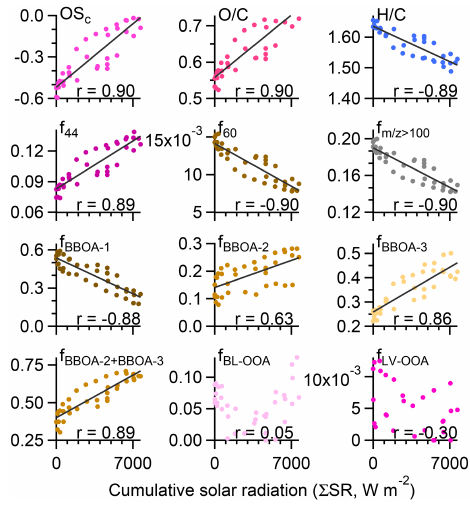
Figure 8. Aerosol chemistry parameters of total BBOA as a func- tion of cumulative solar radiation for the Salmon River Complex fire case study. The Pearson’s correlation coefficients ( r ) are reported.